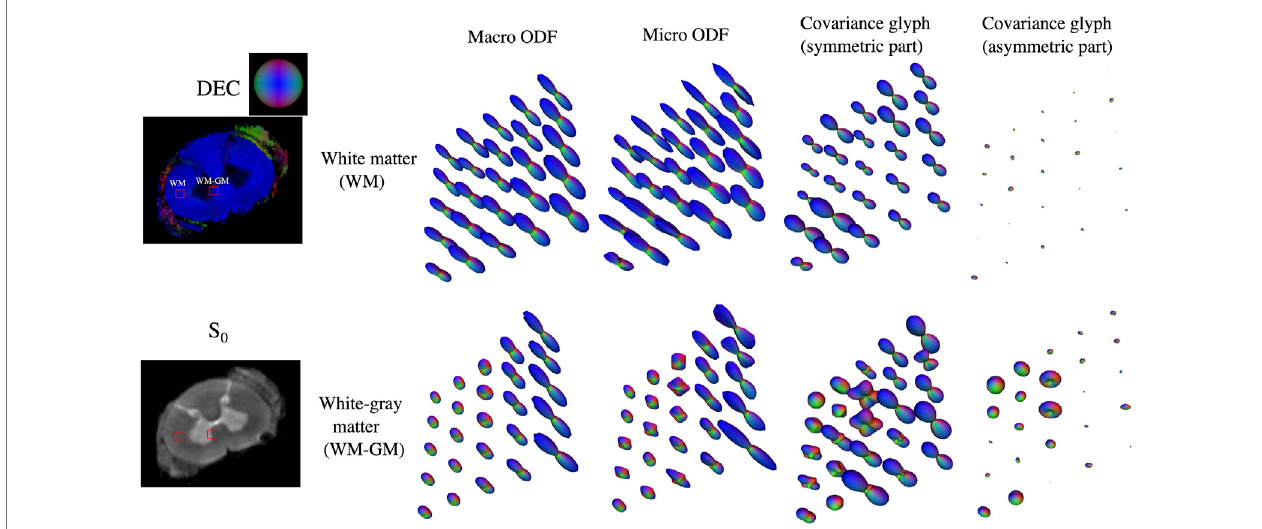
FIGURE 5 | Orientation dispersion observed in macaque cervical spinal cord shown by comparing the macro and micro ODFs. The need for a DTD model and additional information obtained beyond the kurtosis tensor model is demonstrated by plotting the symmetric and asymmetric parts of the covariance tensor of the constrained normal tensor variate distribution. Two regions of interest (ROIs) one in white matter (WM) and gray-white matter (GM-WM) interface regions are highlighted in the direction encoded color (DEC) map, showing the principal direction of the mean diffusion tensor, and S 0 map.